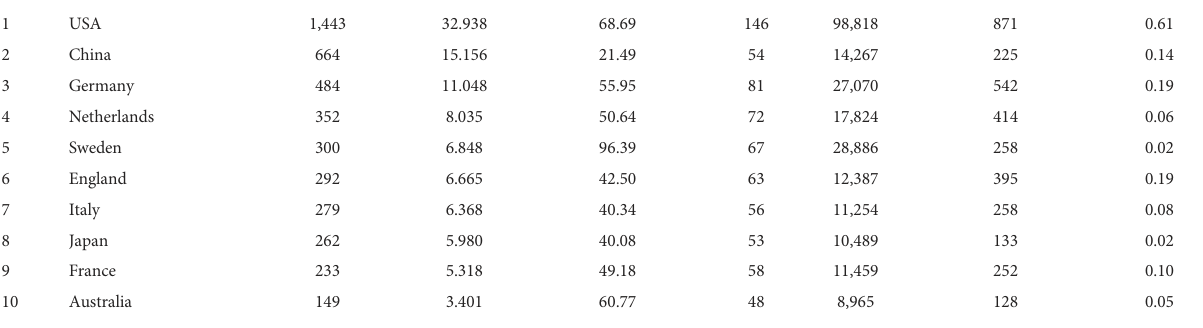
TABLE 2 Top 10 productive countries/regions in T cell and